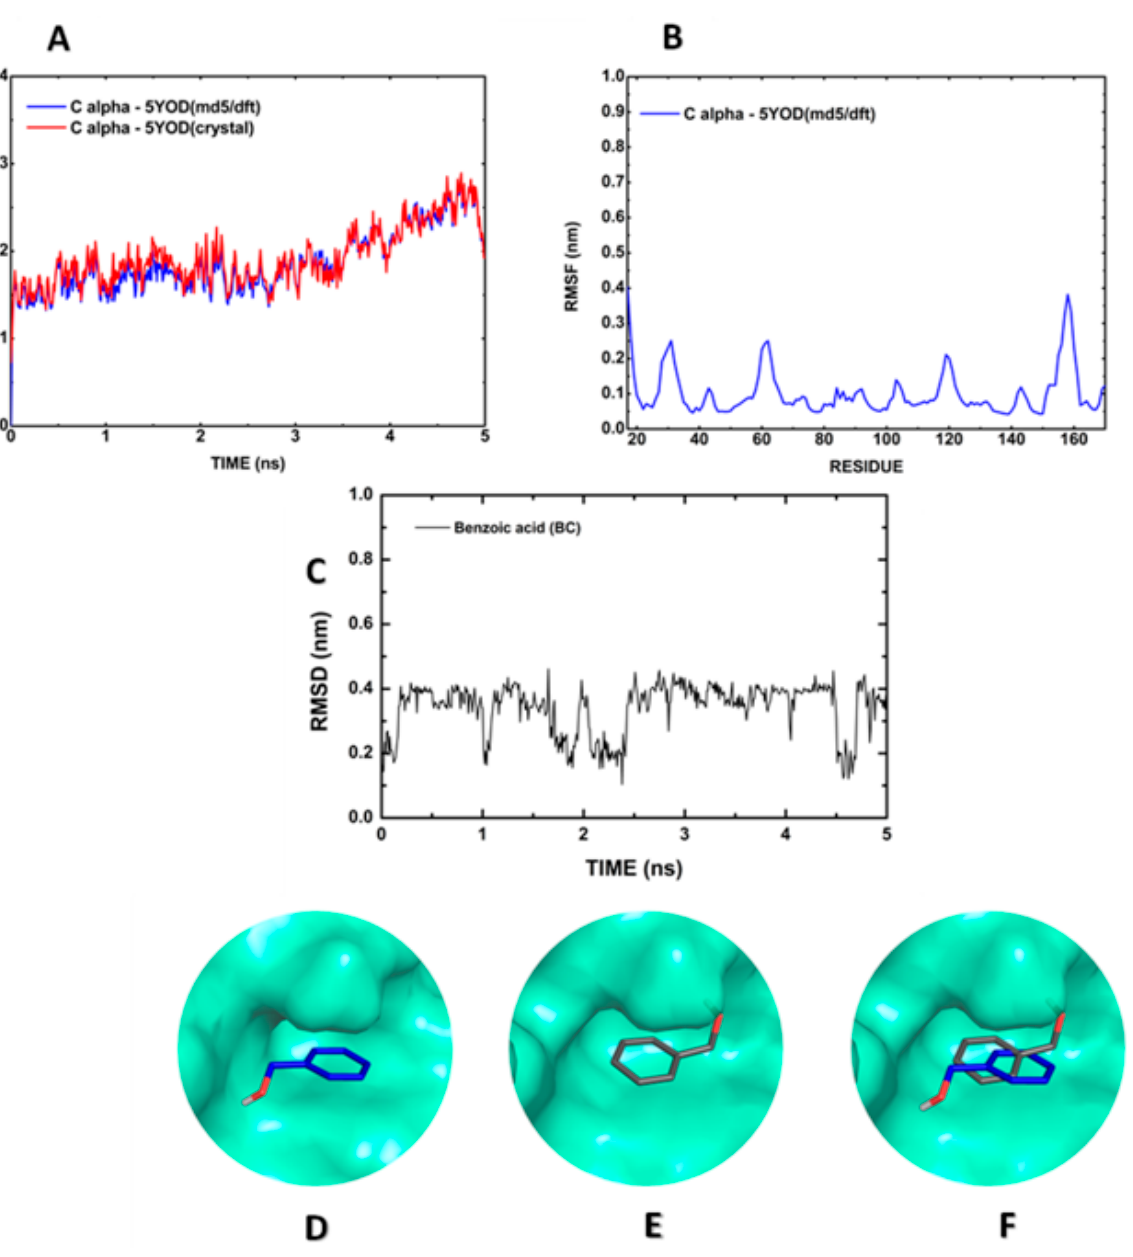
Figure 3. Molecular dynamics simulation of the BC:5YOD structure in water: ( A ) C α RMSD; ( B ) C α RMSF; ( C ) RMSD of BC relative to the protease; ( D ) BC position in the co-crystallized structure; ( E ) BC at 3 ns of the MD; ( F ) superposition of the co-crystallized BC position, and the MD final